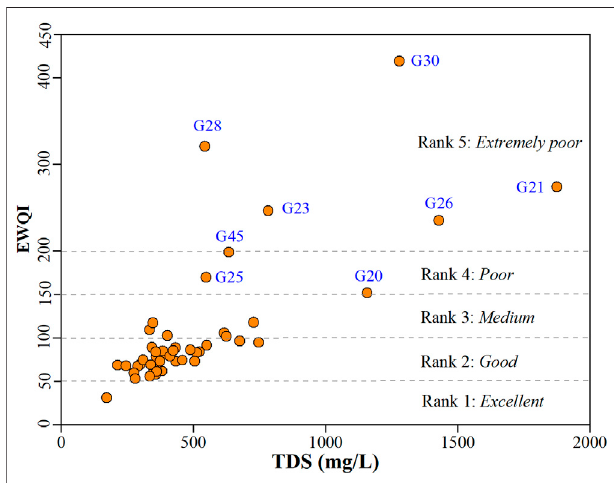
FIGURE 10 | Scatter plots of the TDS versus EWQI of groundwater samples.